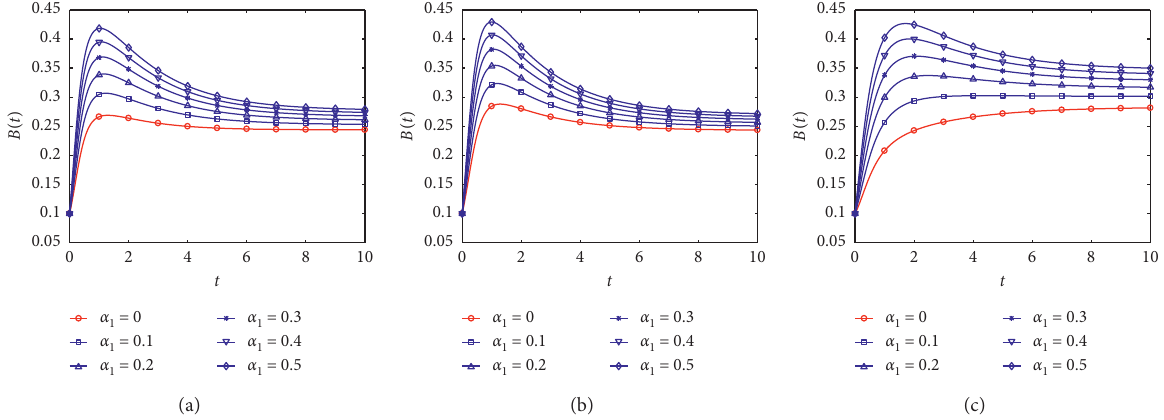
Figure 3: The effect of α on B ( t ) for the three OSNs: (a) Facebook network G F , (b) Twitter network G T , and (c) YouTube network G Y . 1